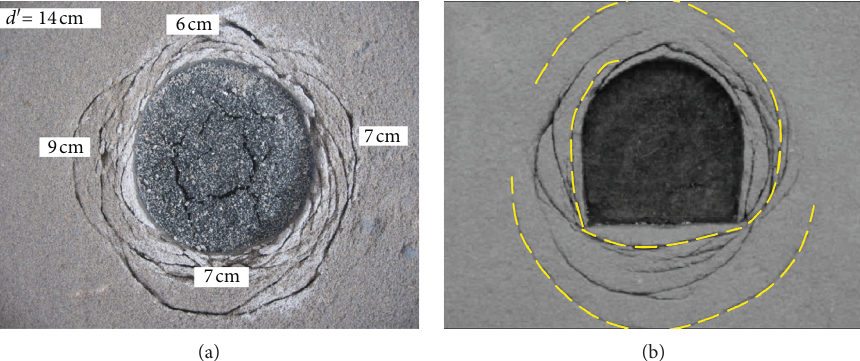
Figure 2: Laboratory test results of zonal disintegration: (a) load after opening excavation [8]; (b) excavation after in situ stress applied